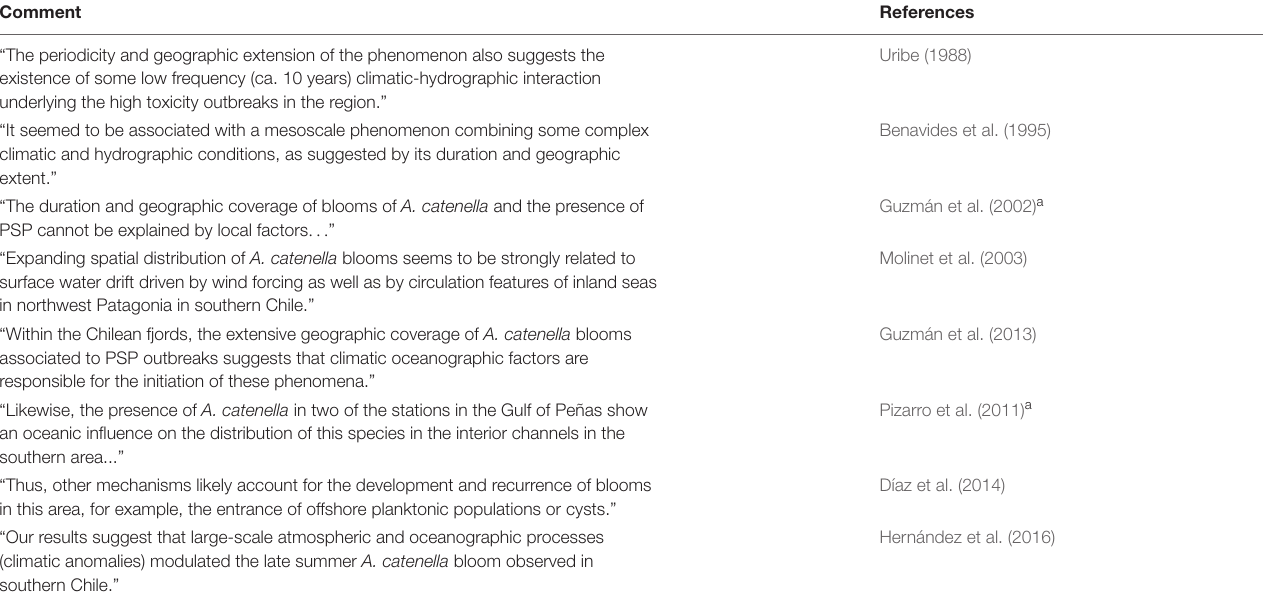
TABLE 2 | Summary of comments regarding potential larger-scale oceanic/climatic influences on blooms of A. catenella in Patagonian and Fuegian regions of southern